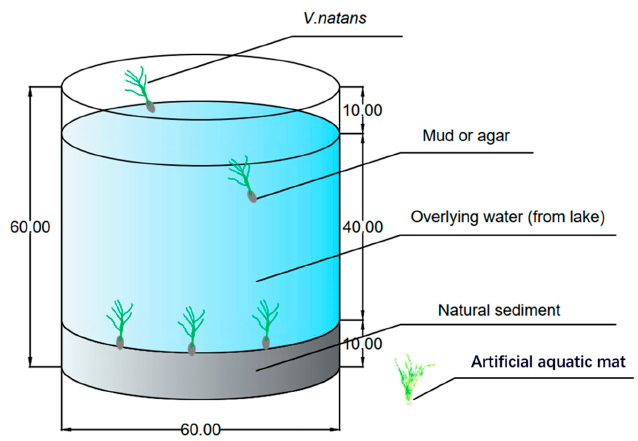
Figure 1. Schematic diagram of the experimental unit (cm).